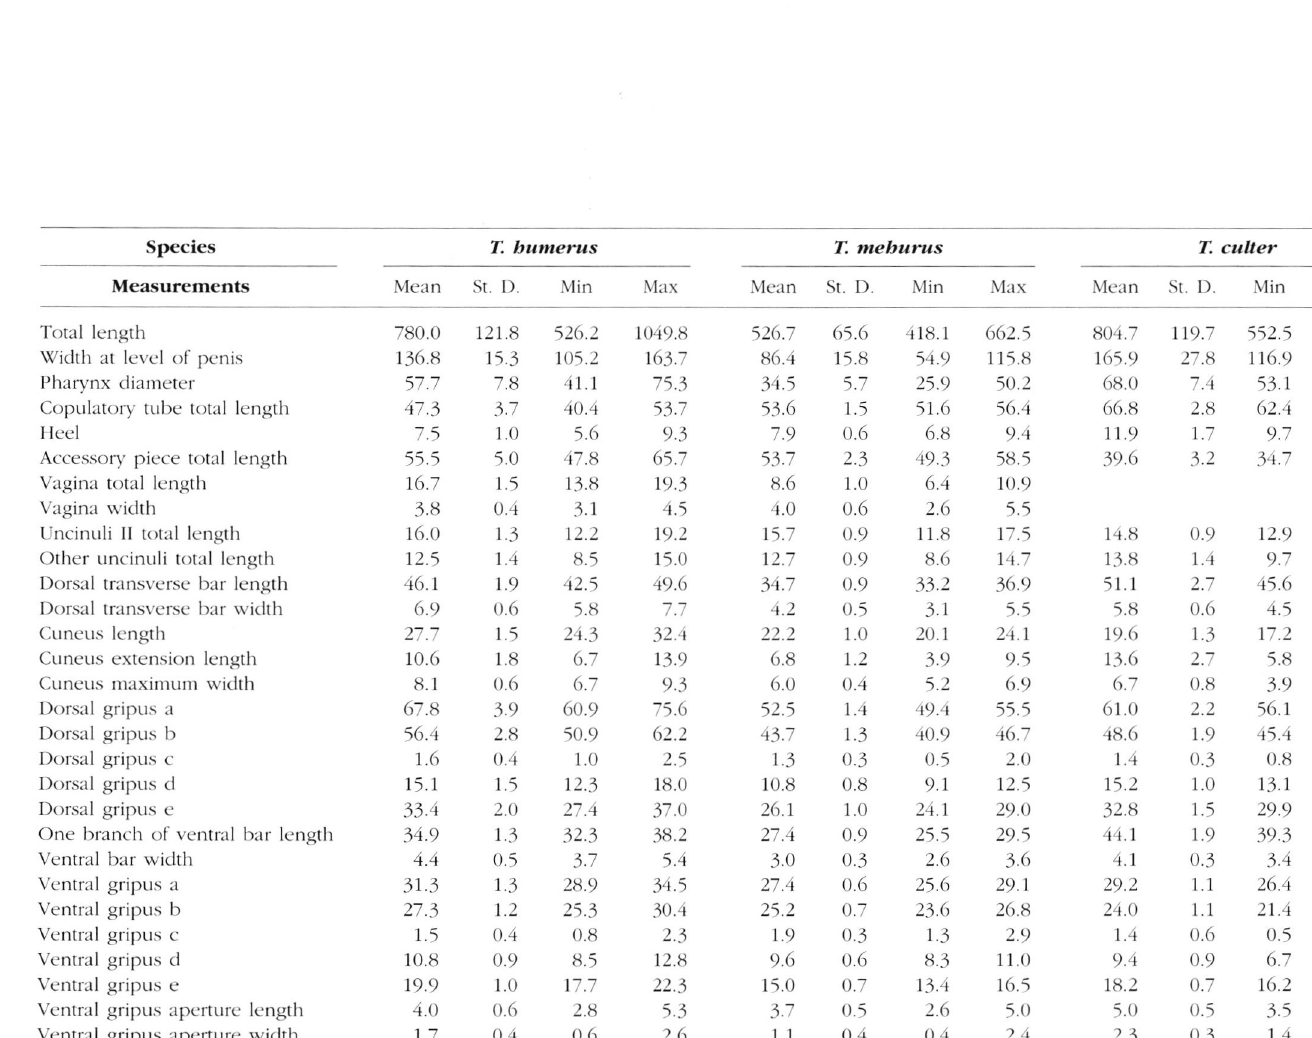
Table I. - Measurcments from T. humérus n. sp.; T. mehurus n. sp.; T. entier n. sp. and T. eutieroides n. sp.